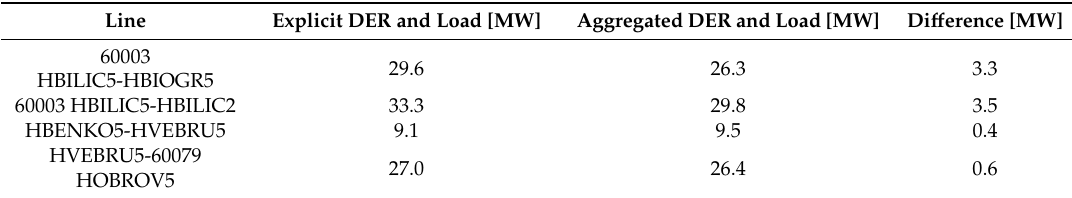
Table 5. Load flow calculation comparison [kV].